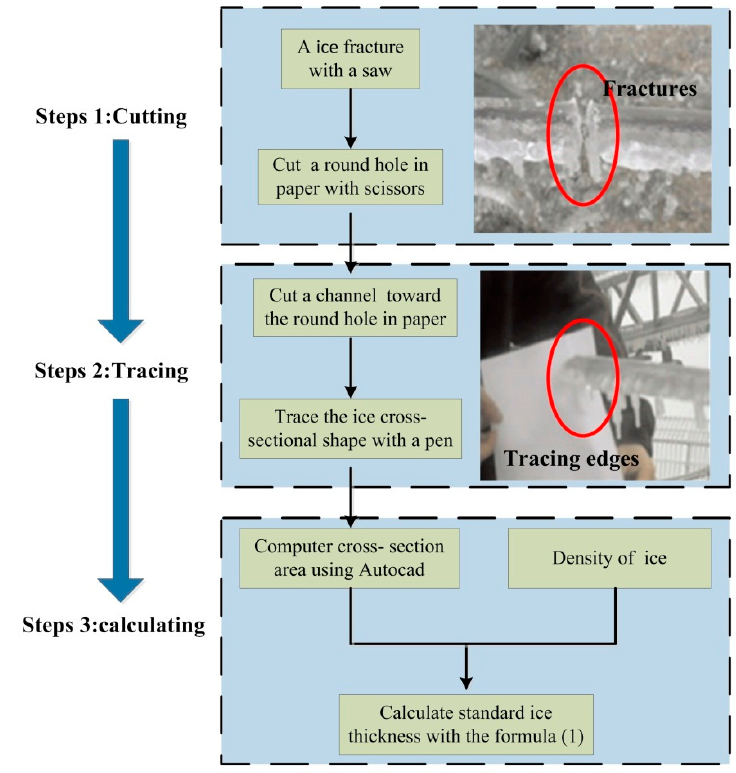
Figure 3. Flow diagram of standard ice thickness of the test conductors.